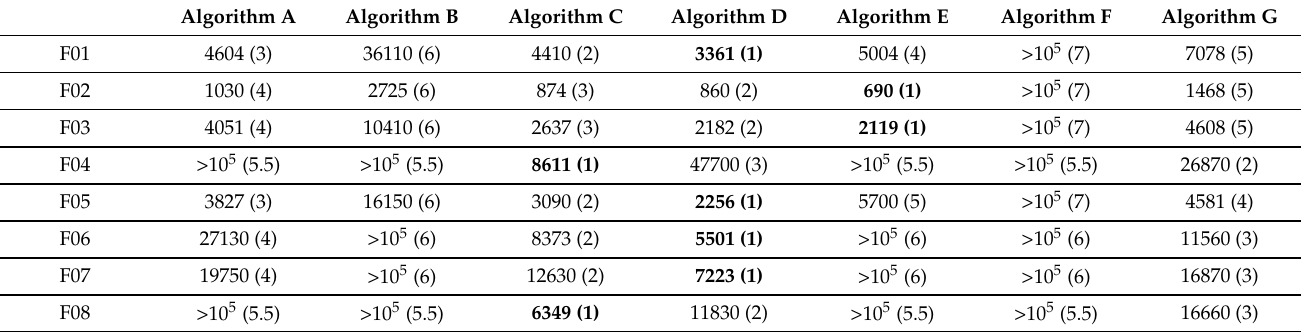
Table 10. Quantiles Q 0.10 of the required number of solutions evaluations with corresponding